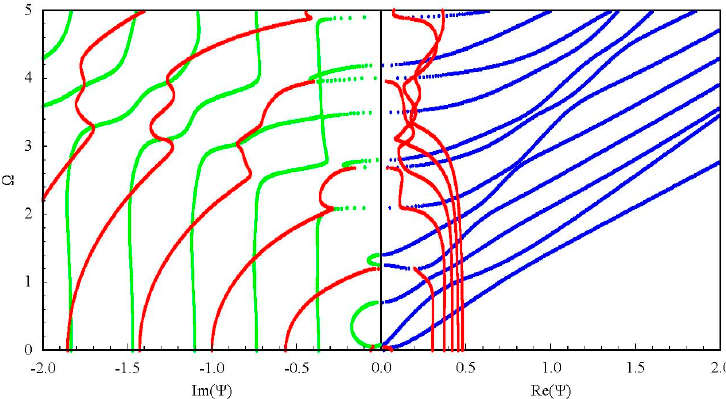
Figure 9. Frequency spectrum of a Lamb-like wave for mechanical free and electricity closed-circuit boundary conditions.